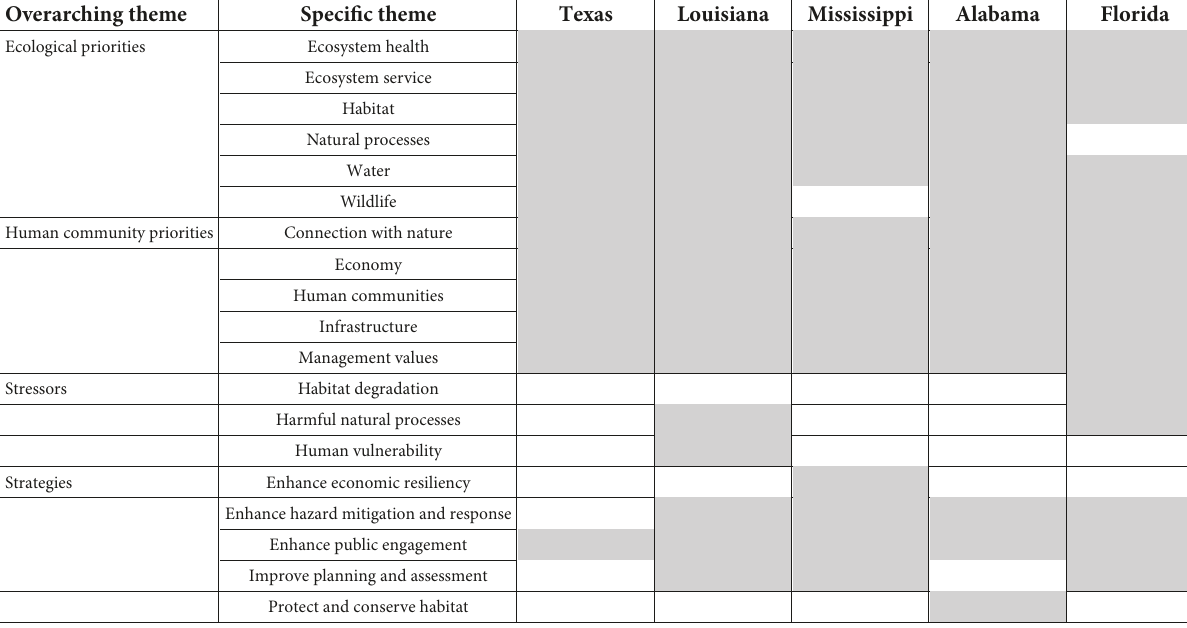
TABLE 2 Shaded cells represent themes present in at least one segment coded as “Fundamental Objectives” across each of the Gulf States. Overarching